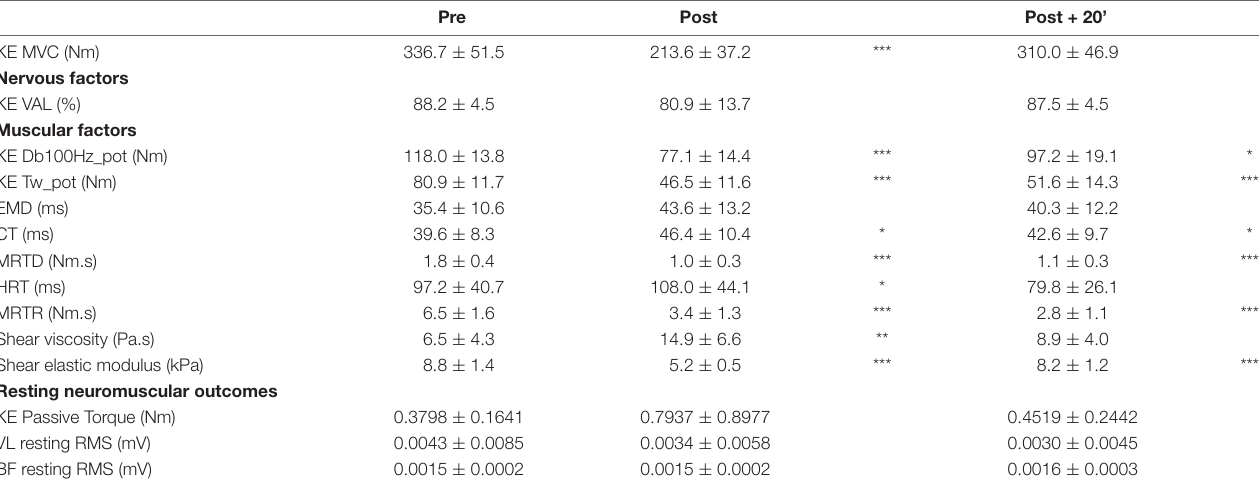
TABLE 1 | Absolute values for both neuromuscular and viscoelastic outcomes before and after